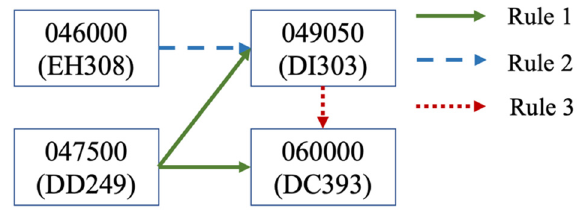
Figure 4. Rules for station–equipment combinations with 70% < support < 75% and confidence > 85% using k-times standard deviation clustering.